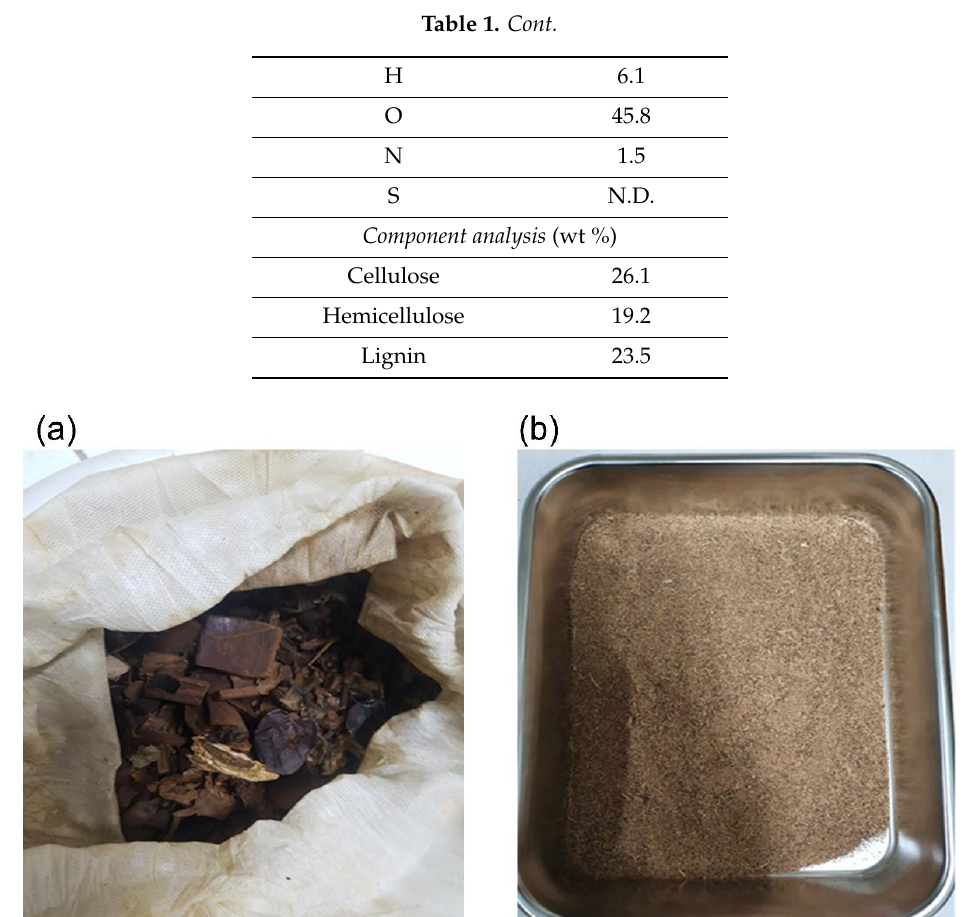
Figure 1. ( a ) Raw herbal medicine waste; ( b ) pulverized sieved powder of the herbal medicine waste dried at 60 °C for 1 d.